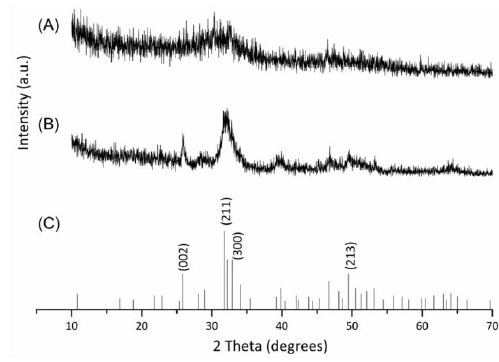
Figure 1. XRD patterns of Hap nanocrystals/ type I collagen composite (nHap/Col composite) scaffold after ( A ) 0.5; ( B ) 24 h reaction; and ( C ) standard reference of Hap (JCPDS No. 09-0432).